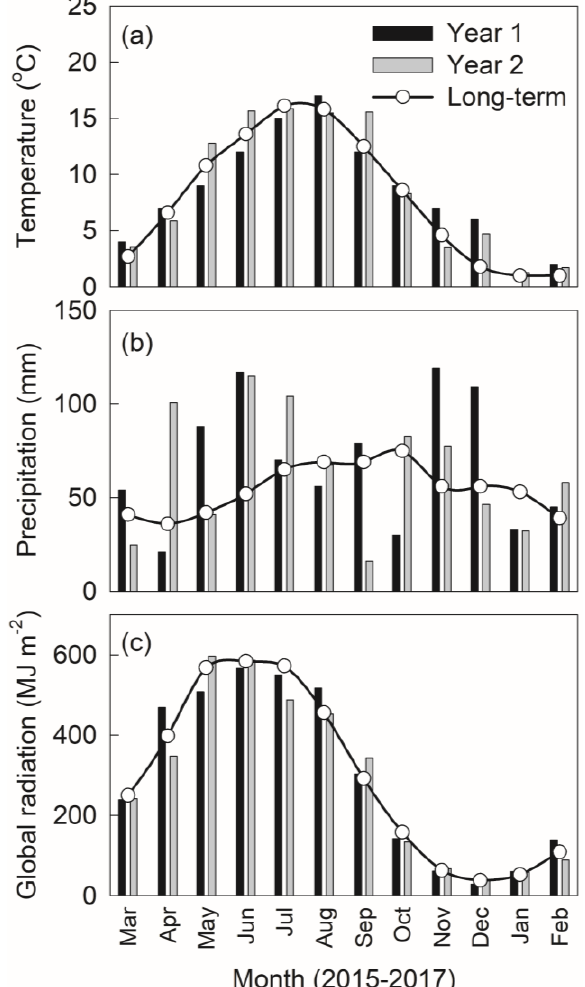
Figure 3. Mean monthly (a) air temperature, (b) precipitation and (c) global radiation in the study area during Year 1 (March 2015 – February 2016), Year 2 (March 2016 – February 2017), and during the long-term period